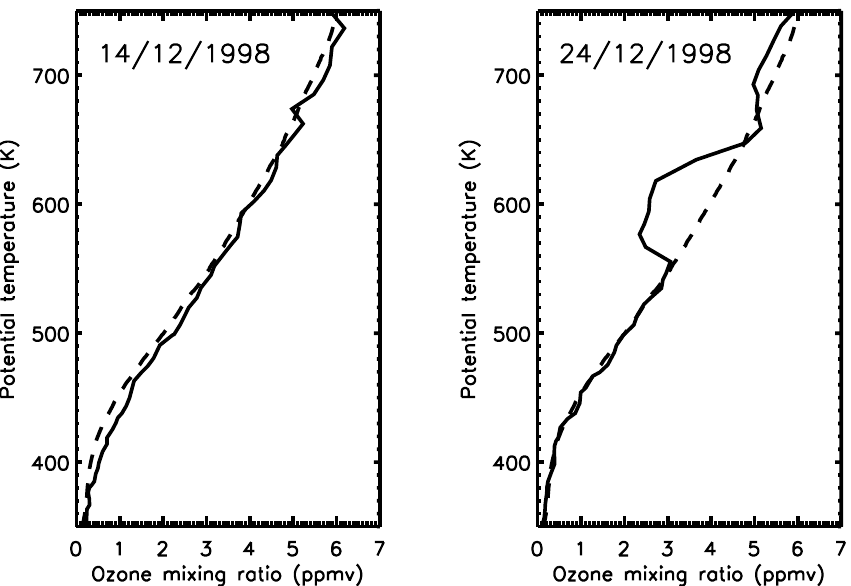
Fig. 1. Vertical profiles of ozone (between potential temperature surfaces of 350 and 750K) for 14 and 24 December 1998, over Lauder, New Zealand (full line). The ozonesonde climatology for the month of December (1986–2001) is plotted for comparison (dashed